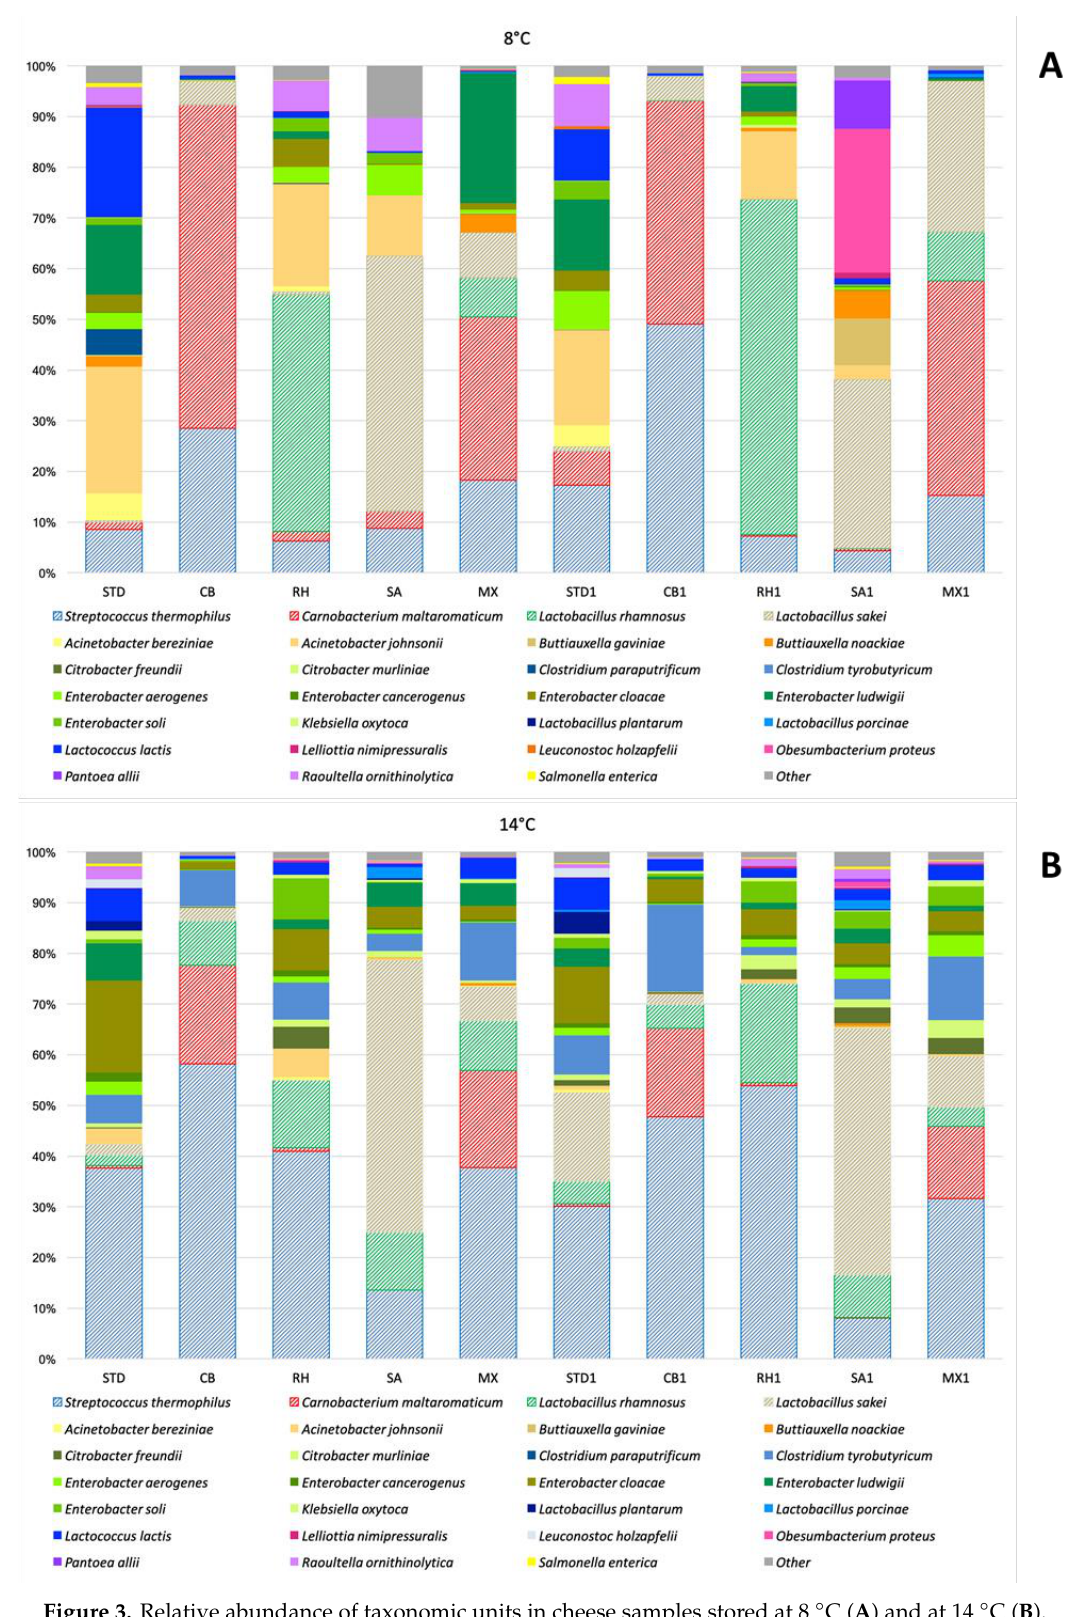
Figure 3. Relative abundance of taxonomic units in cheese samples stored at 8 °C ( A ) and at 14 °C ( B ). STD: control; CB: C. maltaromaticum CNB06; RH: Lcb. rhamnosus RH05; SA: Llb. sakei LSK04, MX: mix of the three adjunct strains. The number 1 after the culture code indicates the strains intentionally spiked with ten strains of spoilage bacteria. Dashed bars indicated the species used as starter or adjunct cultures.